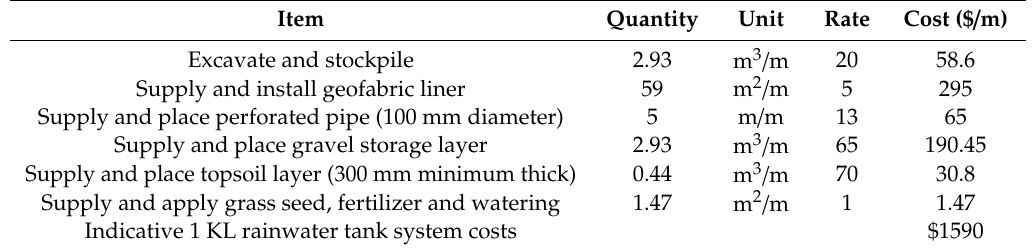
Table 7. Unit cost of smallest allotment (area 496 m 2 ) for the water sensitive urban design (WSUD) process